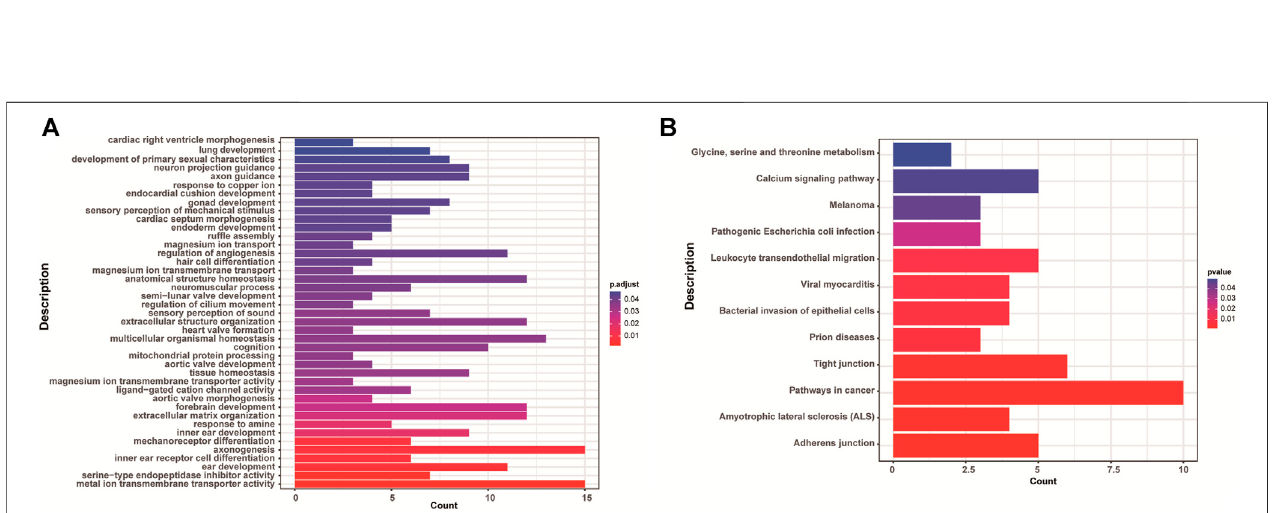
FIGURE 3 | Enriched functions (A) and pathways (B) with adjust p < 0.05 of GO analysis and KEGG analysis.